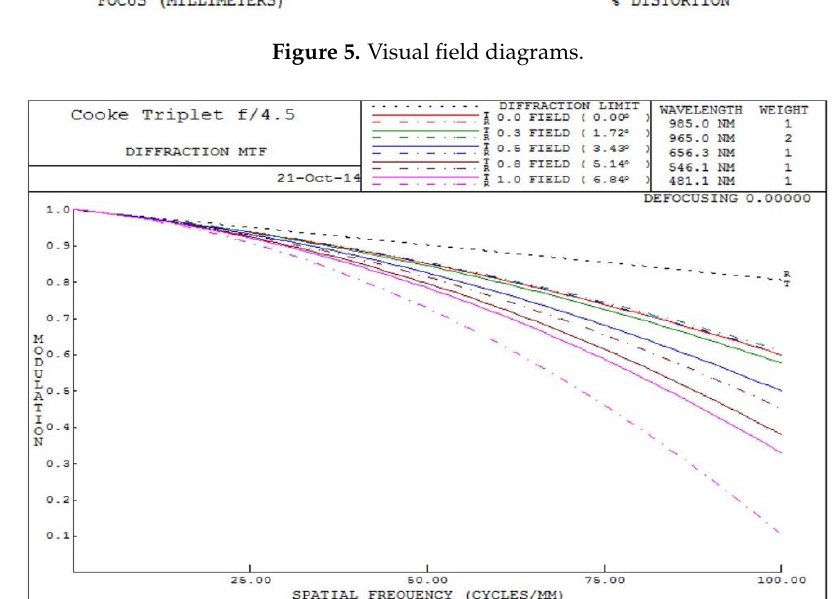
Figure 6. MTF curves of proposed optics.